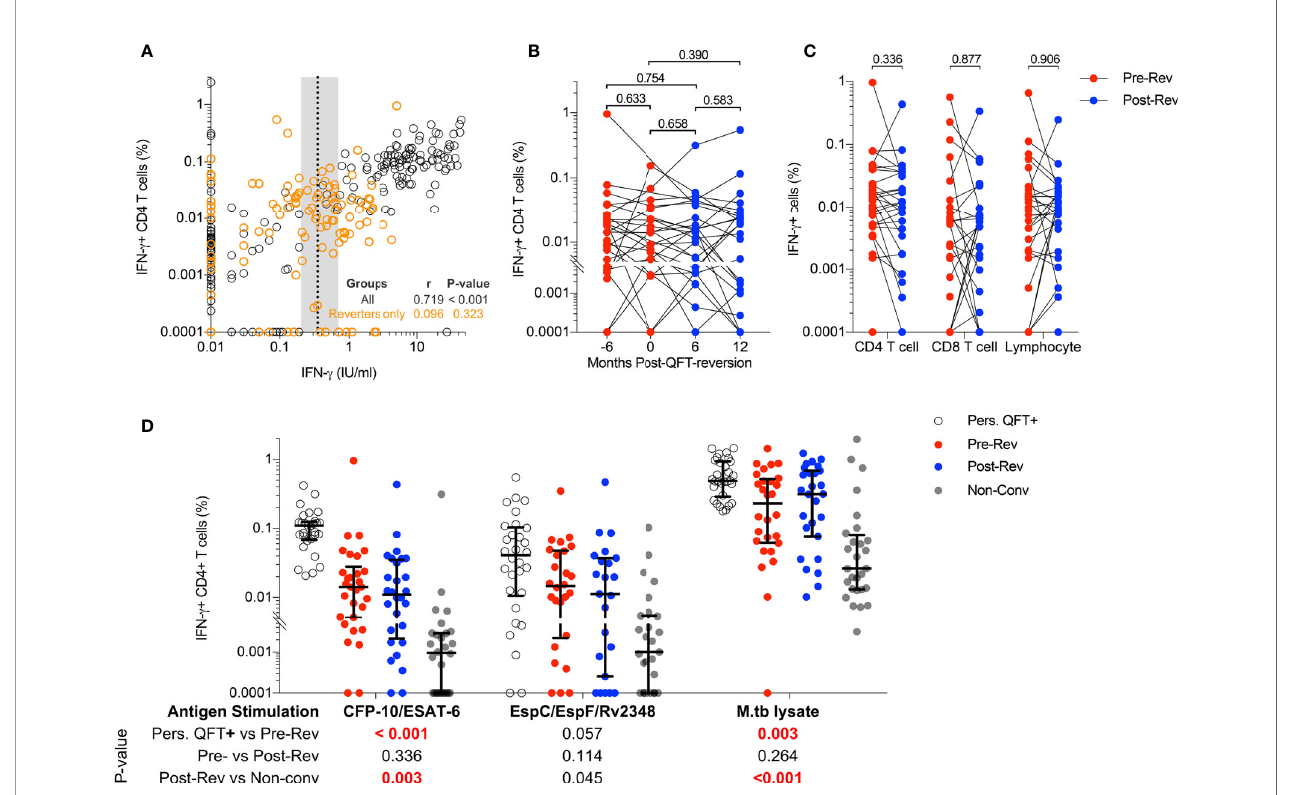
FIGURE 1 | Immunodominant M.tb-speci fi c IFN- g + CD4 T cells are maintained during QFT reversion. (A) Immune responses detected by fl ow cytometry (% of CFP- 10/ESAT-6-speci fi c IFN- g + CD4 T cells) and QFT-ELISA (IFN- g + IU/mL). All participants and all visits are shown (n = 321). Dotted line and shaded area represent the QFT cut-off (0.35 IU/mL) and the uncertainty zone (0.2-0.7 IU/mL), respectively. The Spearman ’ s correlation coef fi cient (r) was calculated on the entire cohort (black) and reverters only (orange). (B) Frequencies of background subtracted CFP-10/ESAT-6-speci fi c IFN- g + CD4 T cells detected in QFT reverters at Month -6: n = 26 (QFT+, red symbol), Month 0: n = 25 (QFT+, red symbol), Month 6: n = 28 (QFT-, blue symbol) and Month 12: n = 26 (QFT-, blue symbol) post QFT reversions. (C) Median frequencies of CFP-10/ESAT-6-speci fi c IFN- g + among CD4 and CD8 T cells and total lymphocytes, measured pre- (n = 30, red symbol) and post- (n = 28, blue symbol) QFT reversion. (D) CFP-10/ESAT-6- (P10-ES6), EspC/EspF/Rv2348- (Esp) and M.tb lysate- (M.tbL) speci fi c IFN- g + CD4 T cells detected in persistent QFT+ individuals (P10-ES6: n = 29; Esp: n = 30; M.tbL: n = 30, white), pre-reversion (P10-ES6: n = 30; Esp: n = 26; M.tbL: n = 28, red), post-reversion (P10-ES6: n = 28; Esp: n = 23; M.tbL: n = 27, blue) and non-converters (P10-ES6: n = 28; Esp: n = 27; M.tbL: n = 28, grey). P-values were calculated using the Wilcoxon signed rank test for comparison of responses from reverters only, and Mann-Whitney test for persistent QFT+ vs pre-reversion and post-reversion vs non- converters. P-values < 0.05 for (A) , < 0.01 for (B) and < 0.0125 (for C, D ) were considered signi fi cant after correction for multiple